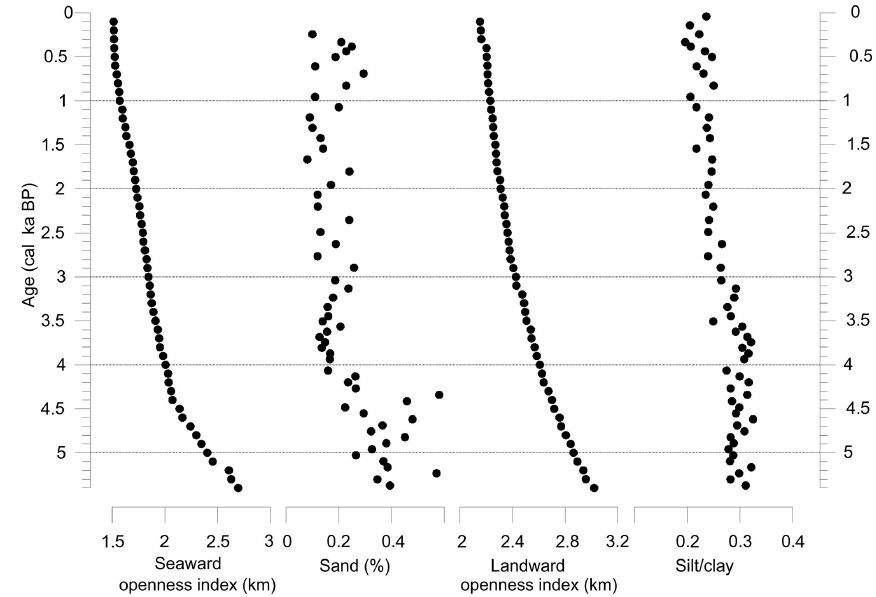
Figure 8. The calculated openness indices using 1 ◦ interval and 0 ◦ shifting and the measured grain size from the